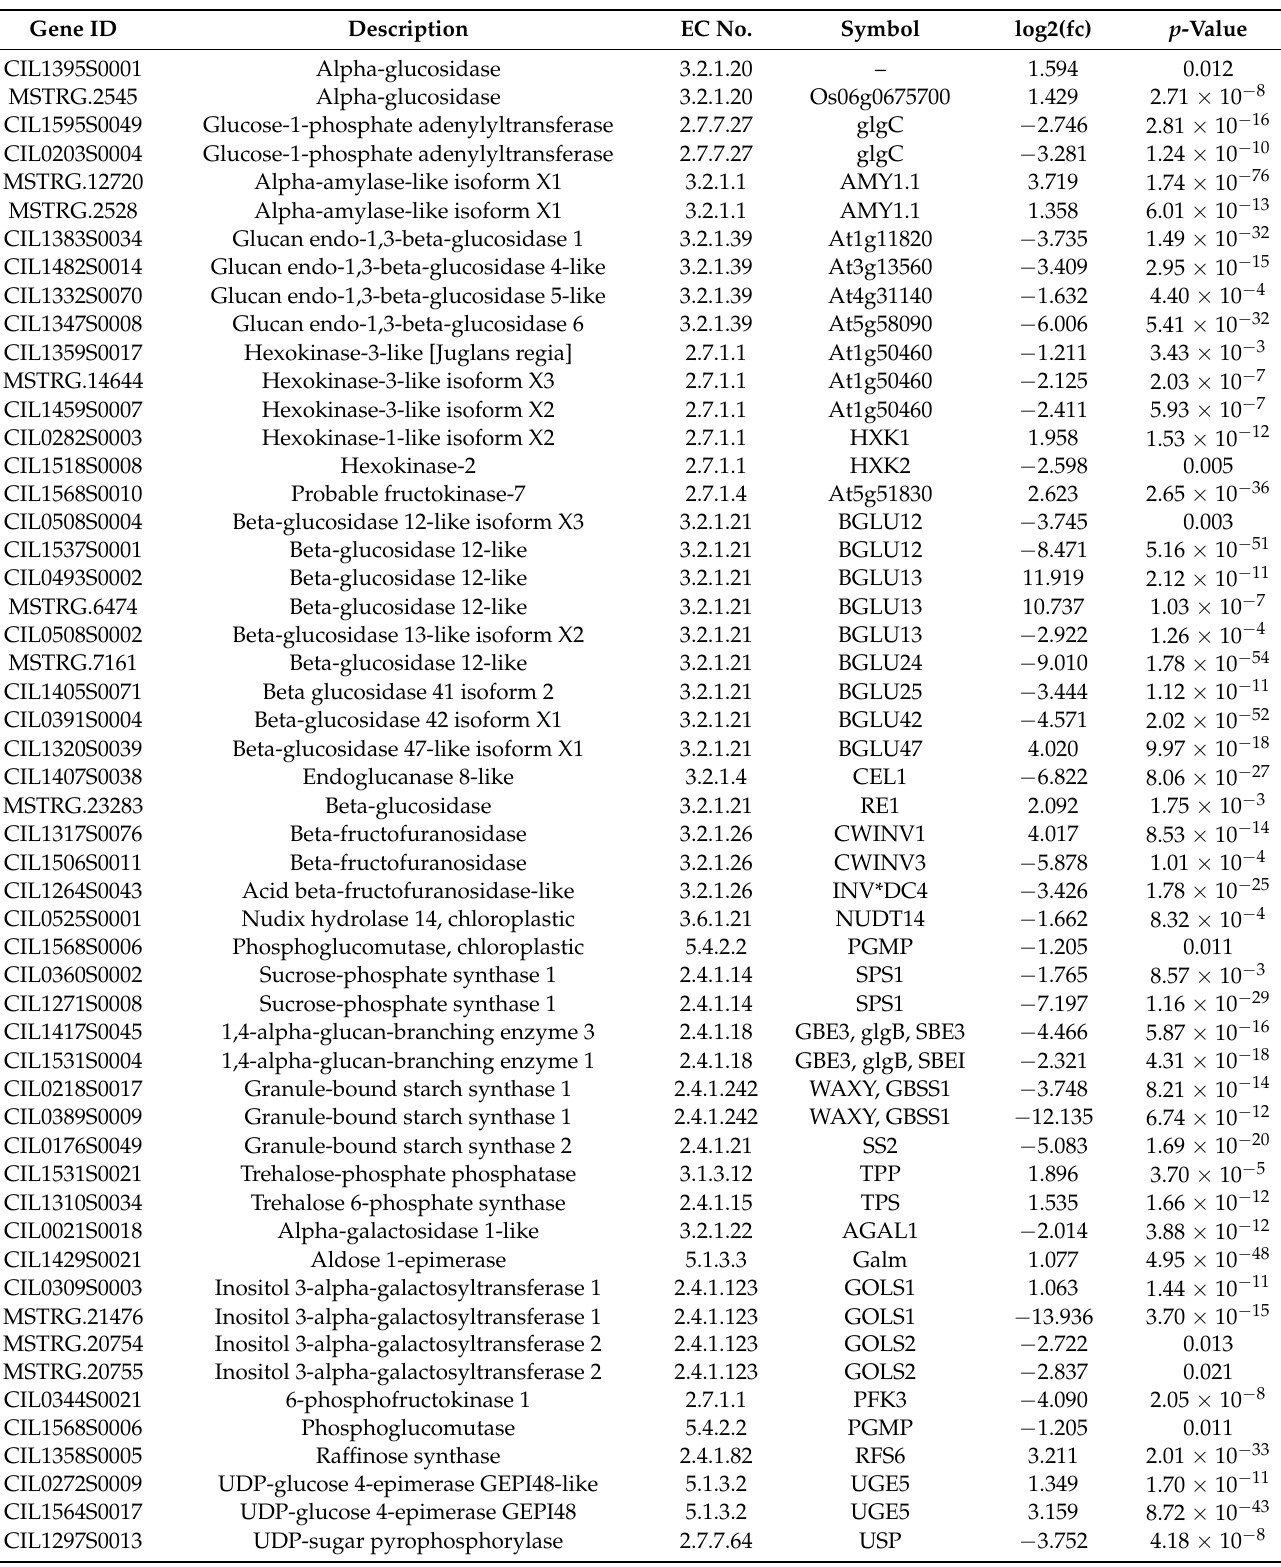
Table 5. Starch and sucrose metabolism and galactose